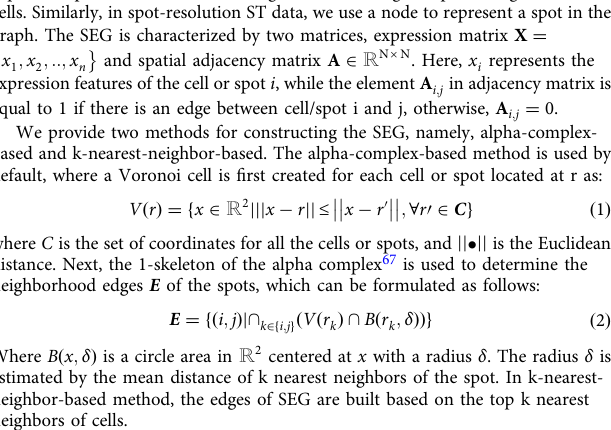
Fig. 5 SpaceFlow identi fi es tumor-immune cell-cell communication in human breast cancer ST data. a H&E image and annotation from the original study for the spots of sample G in human breast cancer ST data 56 . b Domain segmentation from SpaceFlow. c Spatial visualization of pseudotime calculated by Monocle. d Spatial visualization of pseudotime calculated by stLearn. e The pSM from SpaceFlow. f The pSM versus UMAP component 1 from low- dimensional embeddings colored by annotations from SpaceFlow. g Dot plot of the gene expression of domain-speci fi c markers. The dot size represents the fraction of cells in a domain expressing the marker and the color intensity represents the average expression of the marker in that domain. h Spatial expression of top domain marker genes with anti-cancer, pro-cancer, or dual function labels. i Gene Ontology (GO) enrichment for the top domain-speci fi c genes (48 genes) in the identi fi ed Tumor-Immune-Interface-1 (Tu.Imm.Itfc.1). Enriched GO terms are presented as -log10(p-value) using topGO analysis. P values were obtained using the one-sided Fisher ’ s exact test without multiple-testing correction. P values < 0.005 were considered signi fi cant. Space- constrained CellChat inferred cell-cell communications with cell-cell communications signaling sent from Invasive-1 in Collagen pathway ( j ) and from In- situ cancer 1 in MK & APP pathways (